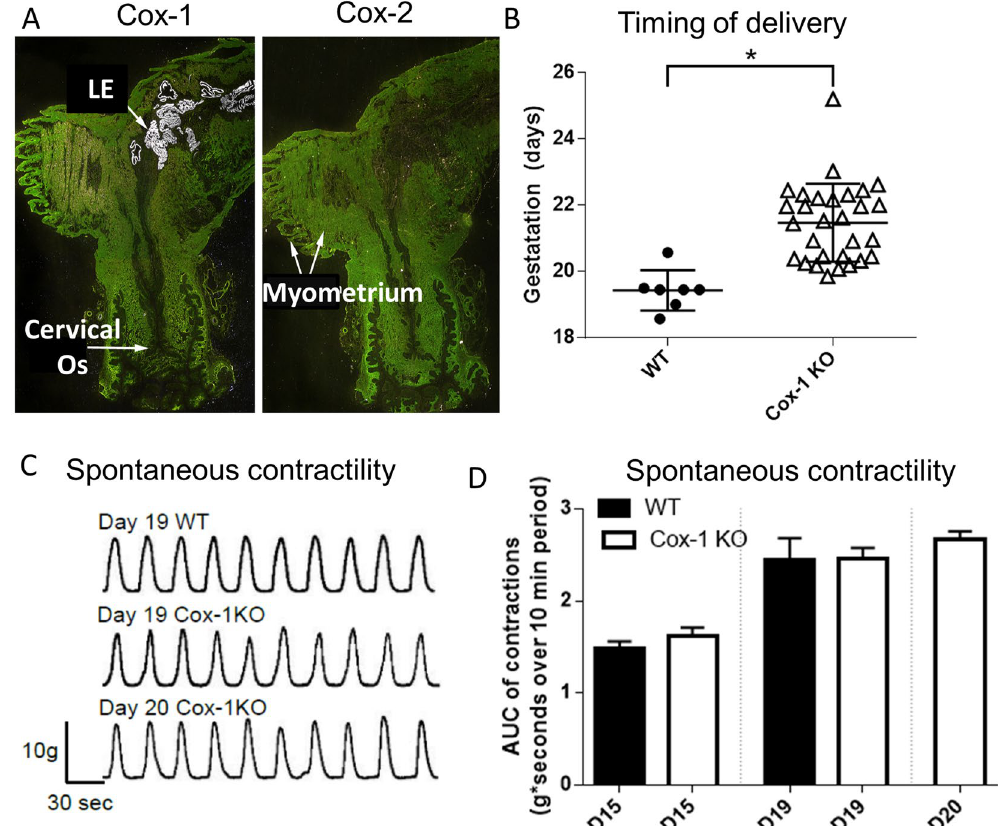
Figure 1. Cox-1 expression in the pregnant mouse uterus, and the effect of global Cox-1 deletion on parturition and uterine contractility. ( A ) In situ hybridization of 35S-labeled Cox-1 and Cox-2 in WT day 19 mouse uterus. ( B ) Timing of delivery was recorded from pregnant WT and Cox-1 KO mice ( * p = 0.0001). ( C ) Representative ex vivo contractility tracings of myometrial strips from pregnant mice on the indicated days of pregnancy. ( D ) Recordings of myometrial contractility (n = 5–11 mice per group) were analyzed for area under the curve (AUC). Mean ±